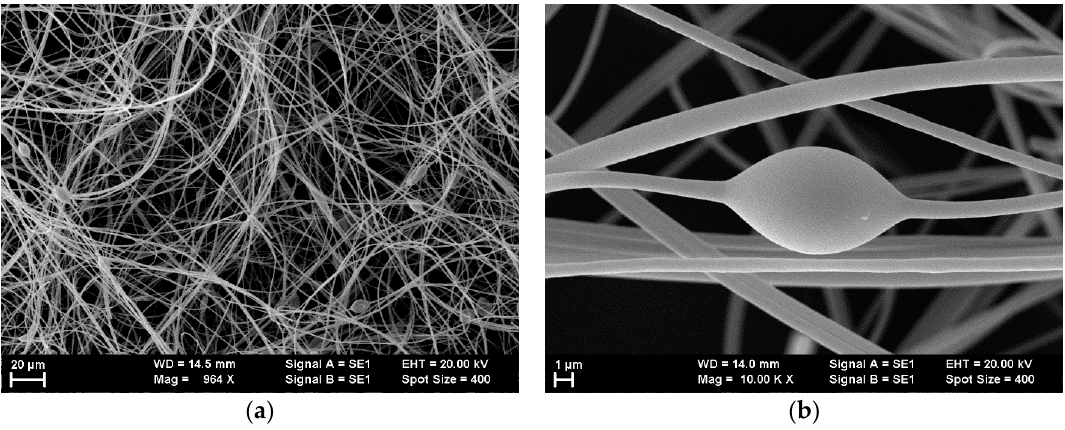
Figure 5. Beads-on-string morphology observed for coumarin 6 (C6) sample: 1000× ( a ), and 10,000× ( b ).